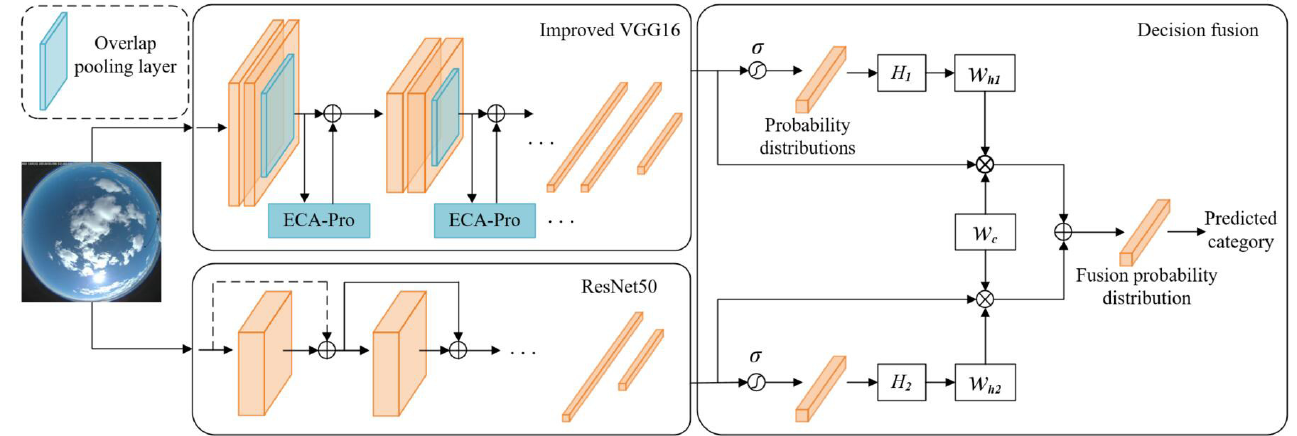
Figure 4. Classification network model of ground-based cloud